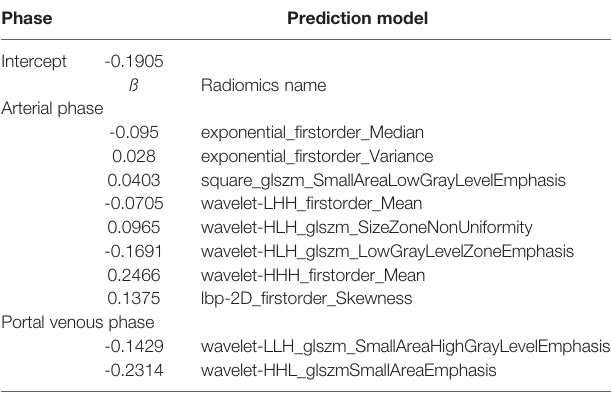
TABLE 2 | The radiomics features selected by Lasso